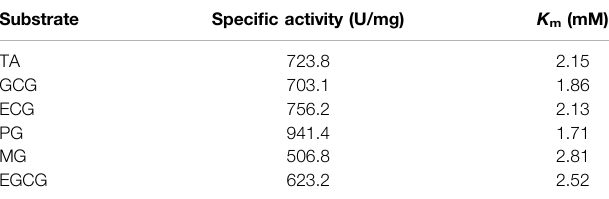
TABLE 2 | Comparison of substrate speci fi cities for TanA.